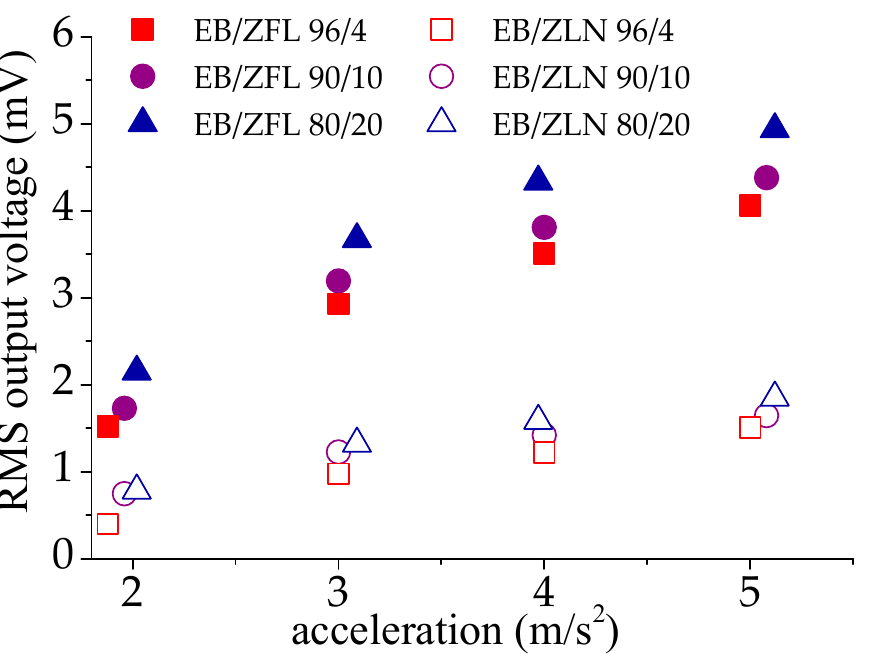
Figure 14. RMS output voltage of EB-ZFL samples with different ZFL amounts at the frequency of 19 Hz vs. the acceleration value.